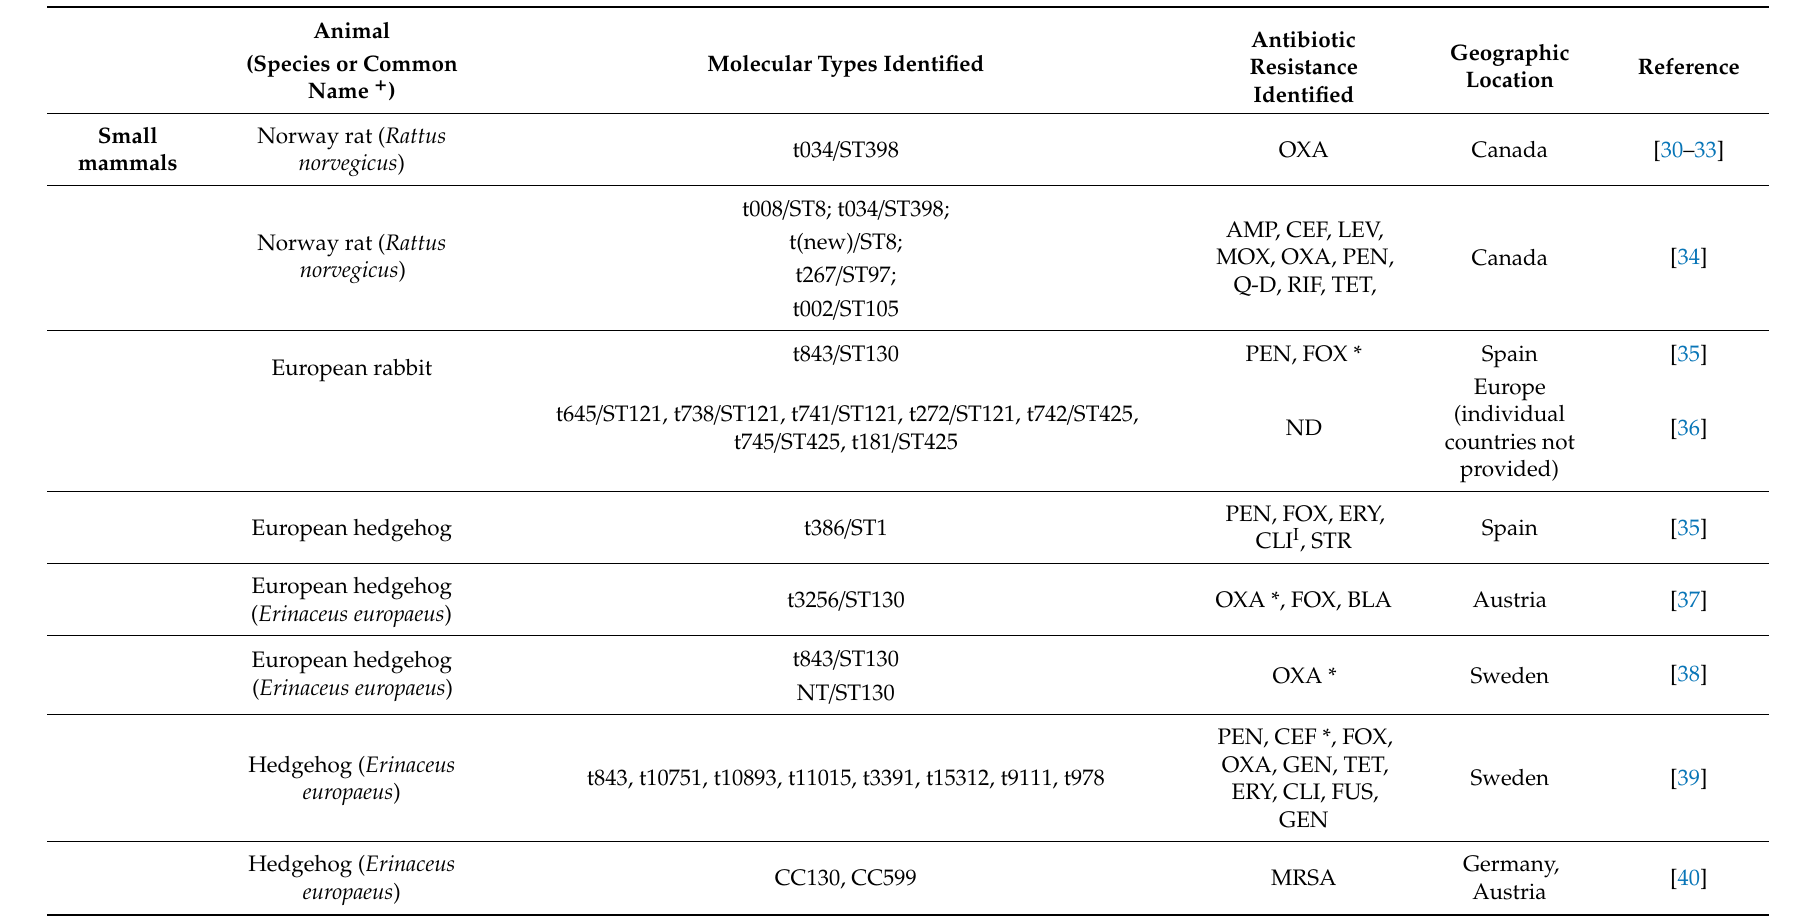
Table 1. Summary of wildlife